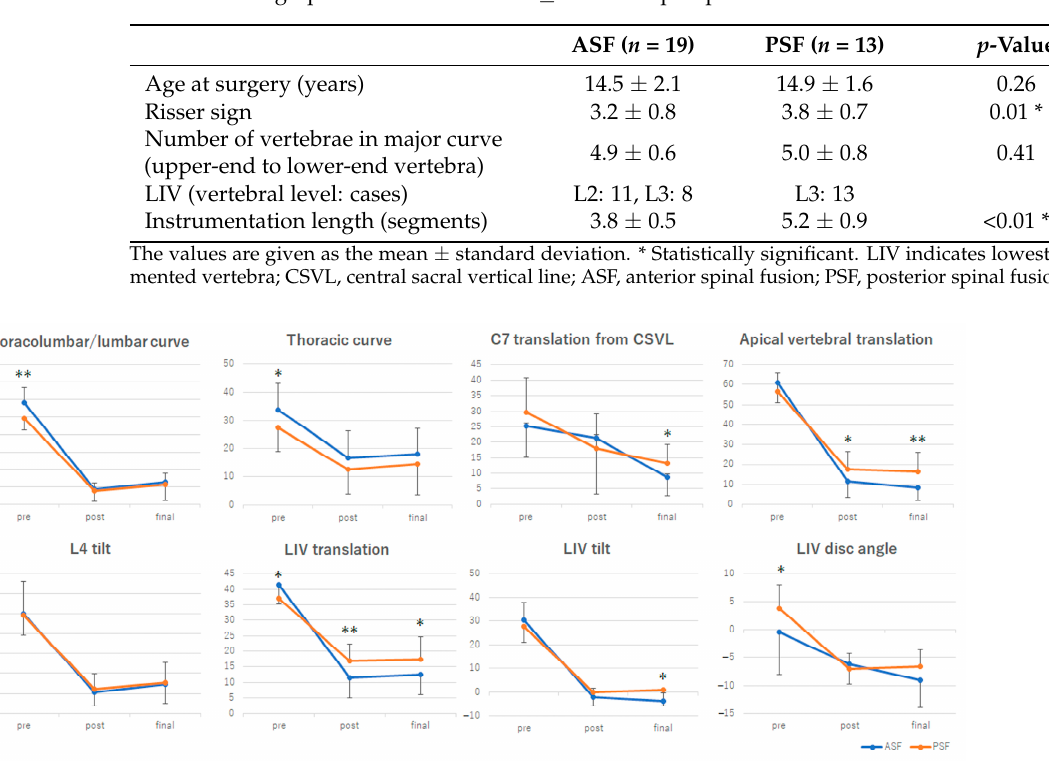
Figure 4. Time course changes in the radiographic parameters of the anterior spinal fusion (ASF) and posterior spinal fusion (PSF) groups in cases with preoperative lowest instrumented vertebra (LIV) translation ≥ 32 mm. CSVL indicates the center sacral vertical line. Error bars represent standard deviation. * p < 0.05, ** p < 0.01.